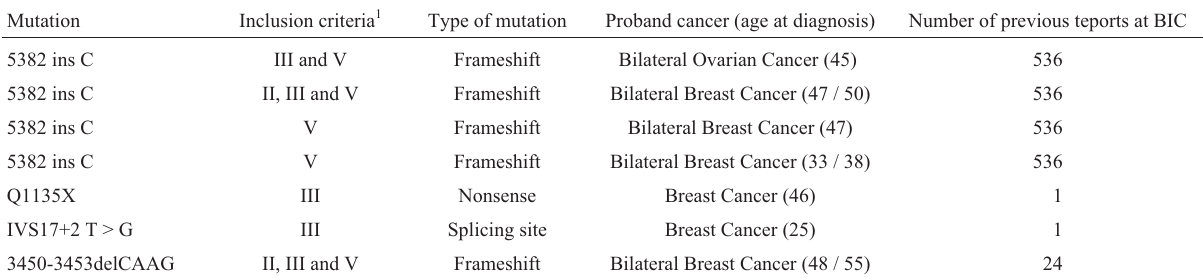
Table 2 - Mutations found in seven unrelated patients, inclusion criteria, type of cancer(s) (age at diagnosis), and number of previous reports at BIC (Breast Cancer Information Core).